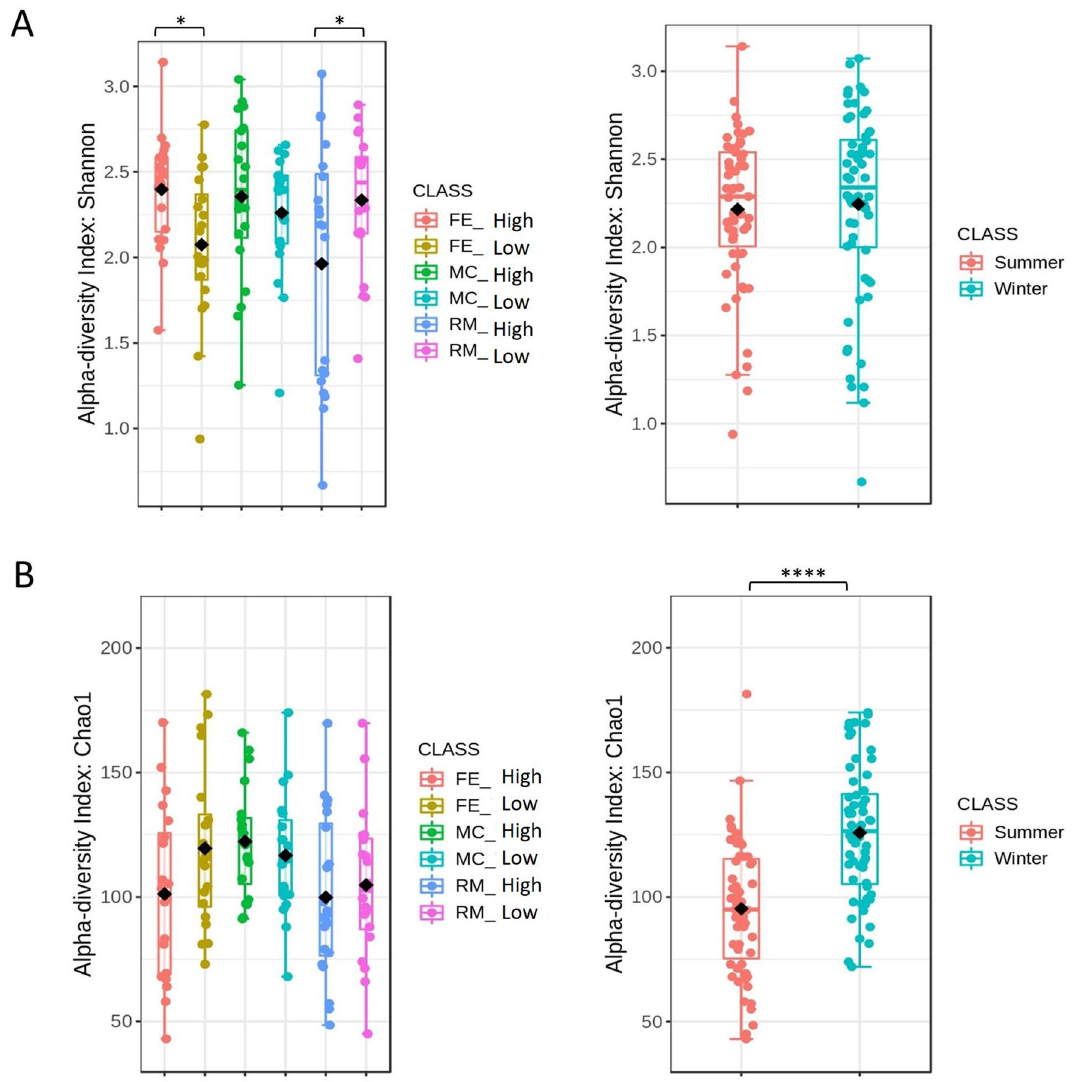
Figure 1. Alpha diversity using the Shannon ( A ) and Chao1 ( B ) indexes. Asterisks represent statistically significant differences between the high and low groups within each trait/season (* p ≤ 0.05; ** p ≤ 0.01; *** p ≤ 0.001; **** p ≤